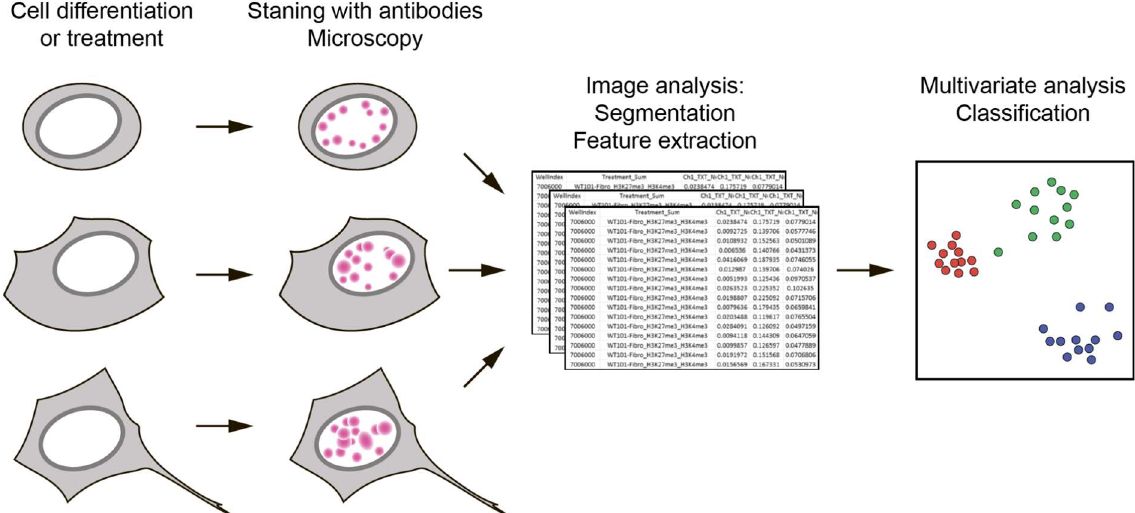
Figure 1. Schematic outline of MIEL. Cells of interest (e.g., cells at different stages of differentiation and cells after drug treatment) are stained using antibodies against target epigenetic modification(s). The obtained intranuclear patterns (landscapes) of distribution of histone modifications undergo computer analysis (texture features extraction). Cells are compared and classified using the mul- tiparametric Euclidean distances between them.